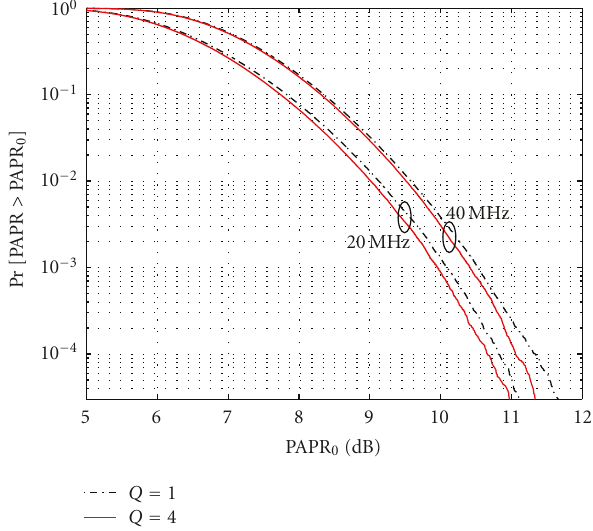
Figure 8: CCDF for Configuration 1 with and without GO-CDM